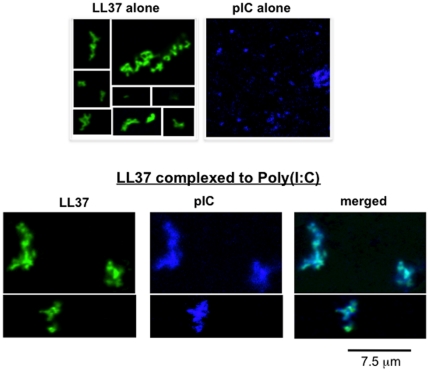
Conformations of FAM-LL37, Cy5-poly(I:C) and the complex of FAM-LL37 and Cy5-poly(I:C).Cy5-poly(I:C) (50 µg/ml) or FAM-LL37 (2 µM) was added either singly or as a mixture to coverslips. The images were obtained on a Leica TCS SP5 confocal microscope (100x objective lens). The images separated by a white line were taken from separate areas within the sample.